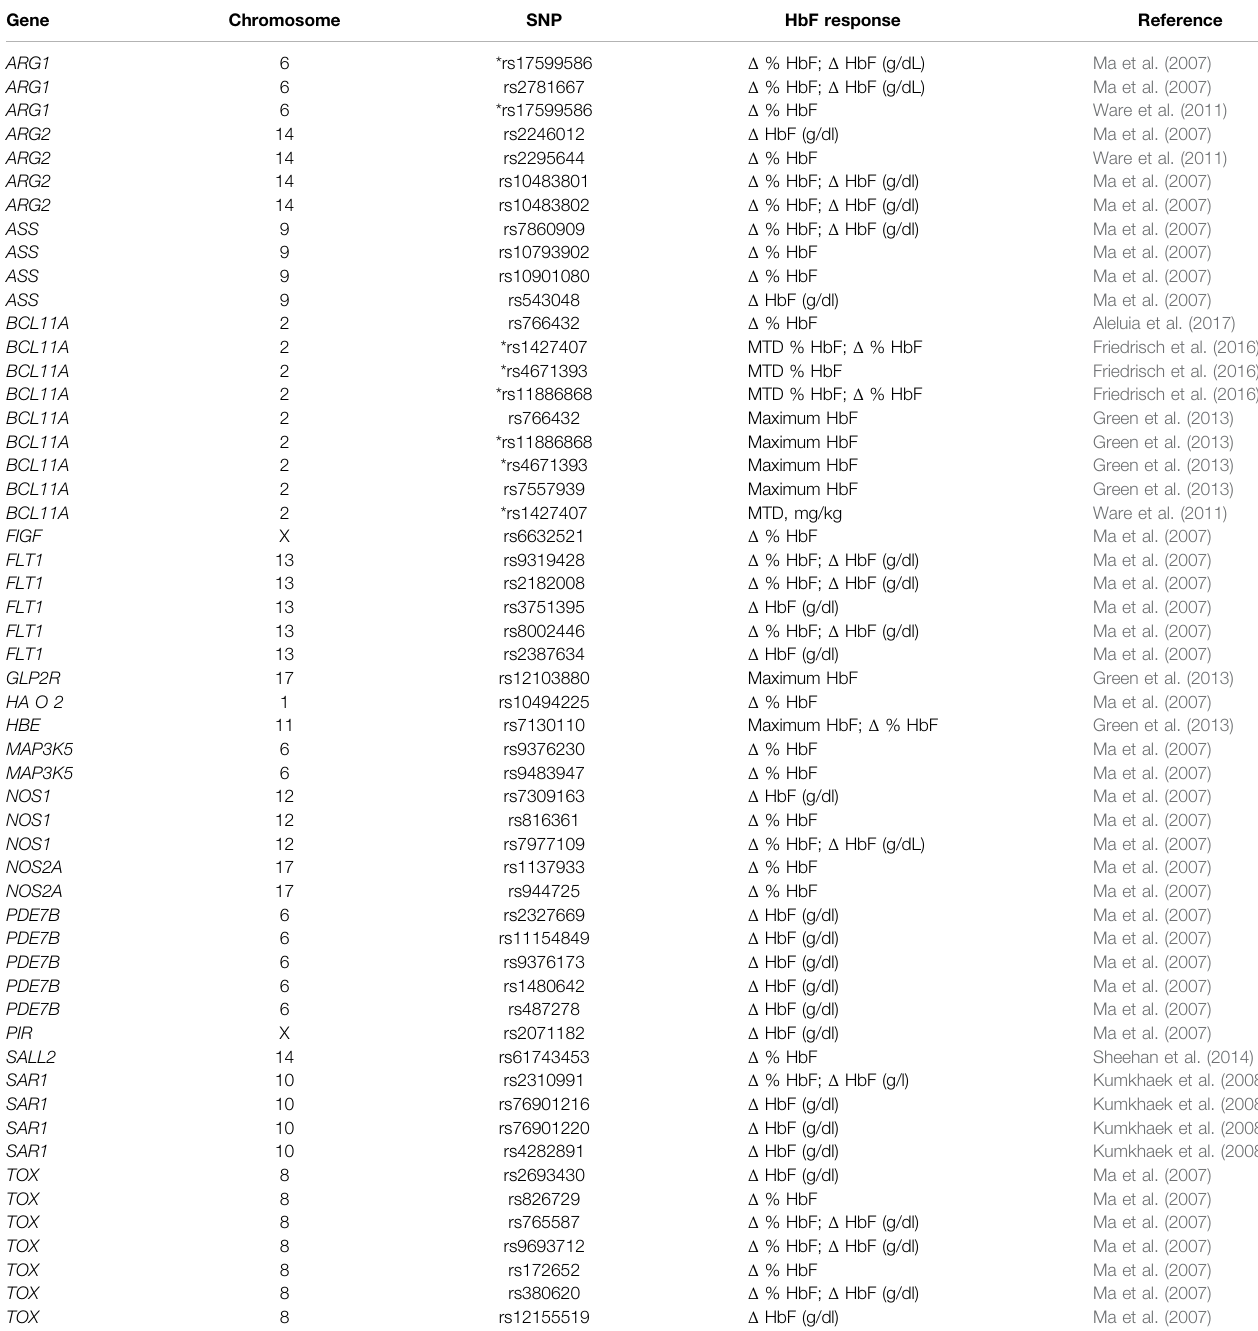
TABLE 2| Genesandchromosomesforthe50differentSNPsfoundtobeassociatedwithchangesonHbF [describedasdelta( Δ )%HbF, Δ HbF(g/dl),maximumtolerated dose(MTD)%HbF,ormaximumHbF]inresponsetohydroxyureatherapyinthesevencohortstudiesincludedinthesystematicreview.*TheSNPrs17599586of ARG1 and three SNPs of BCL11A (rs1427407, rs4671393, and rs11886868) were found to be associated by two different cohort